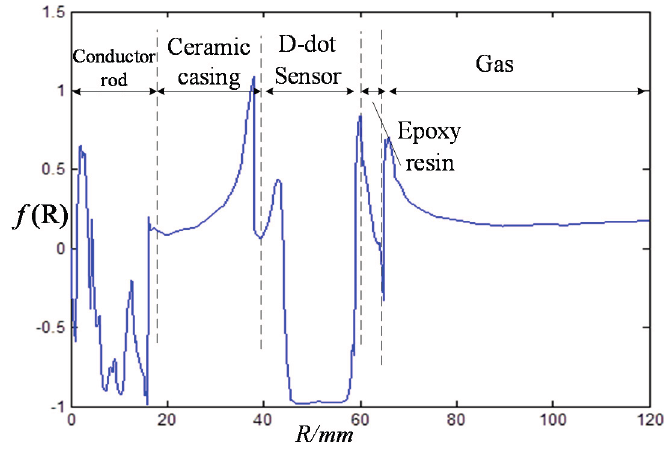
Figure 7. Gradient of electric field